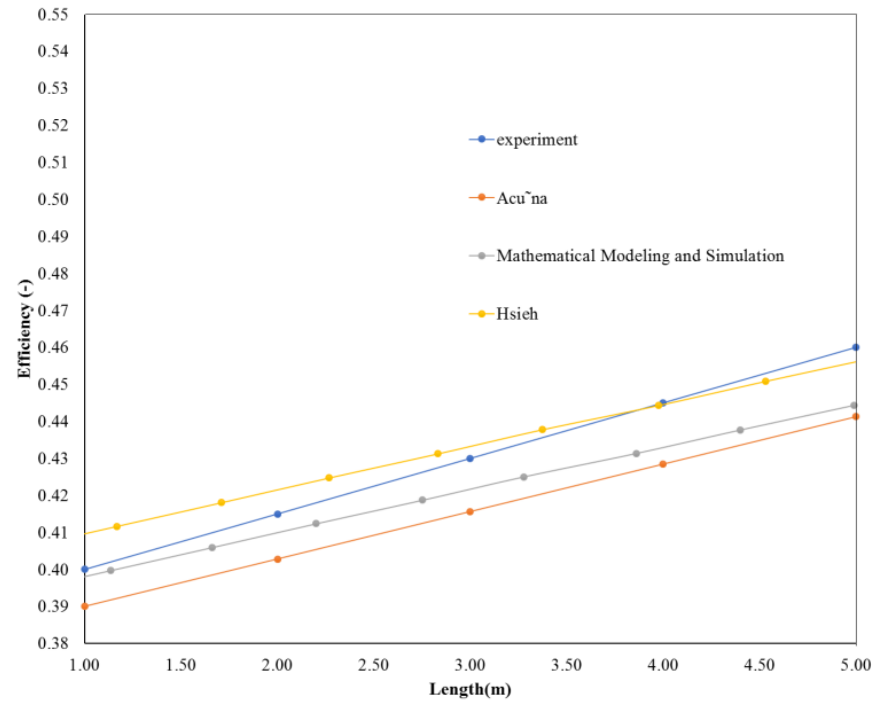
Figure 14. The efficiency of the collector in different lengths of the absorber tube has been compared in similar researches.